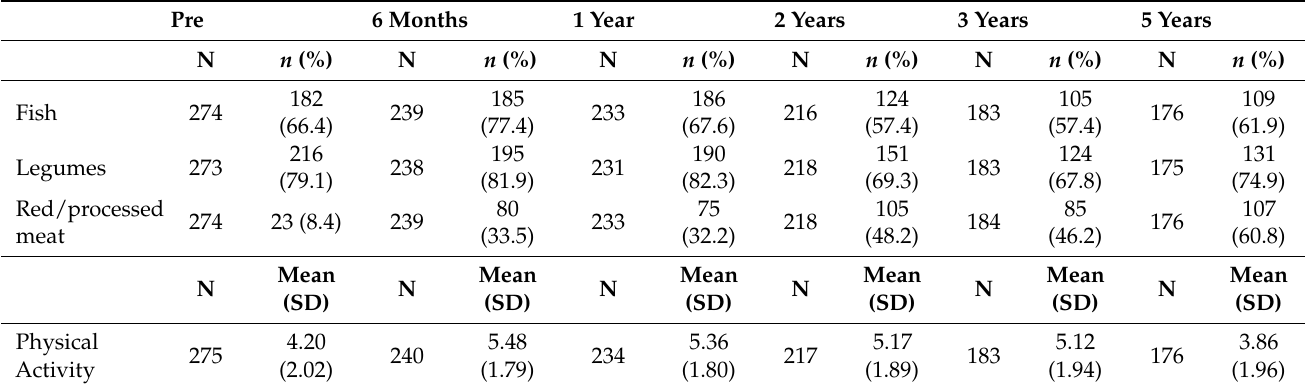
Data on lifestyle behaviors at pre-event were collected retrospectively once patients were